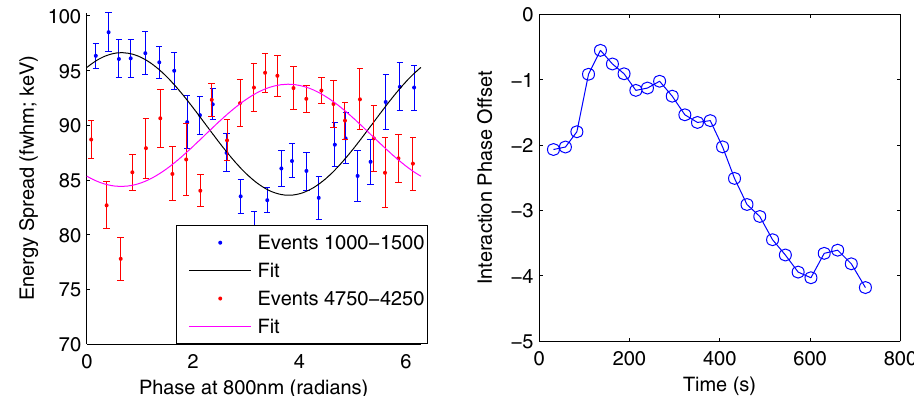
FIG. 5. (Color) Drift of the phase offset between the acceleration phase versus the monitor over time. Left: Two short subsets of a long run show differing phase offset in the energy spread versus phase correlation plot. Right: The phase offset at each subset of a long data scan shows the time evolution of the offset during the full data scan.